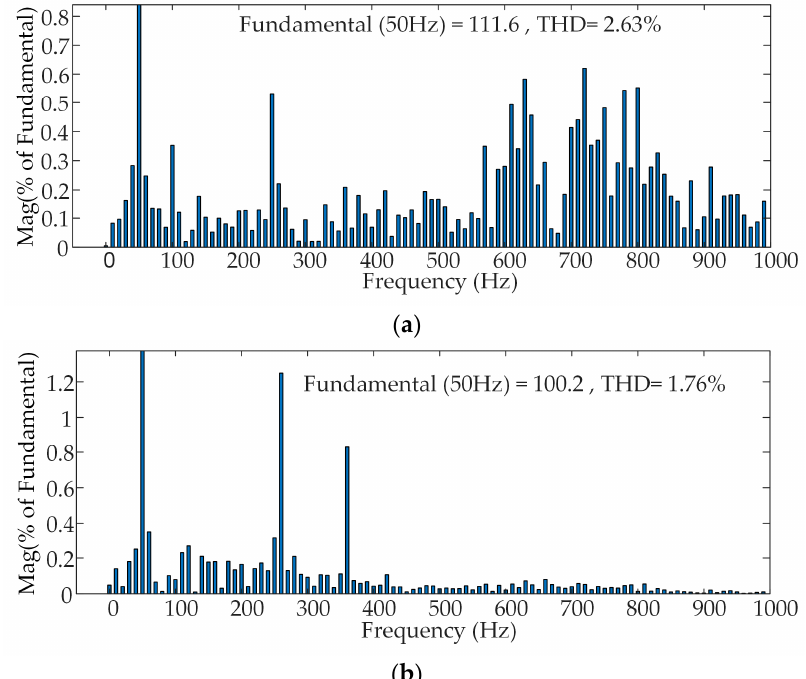
Figure 14. FFT analysis of grid ‐ connected currents. ( a ) FFT under PI control; ( b ) FFT under QPR control.